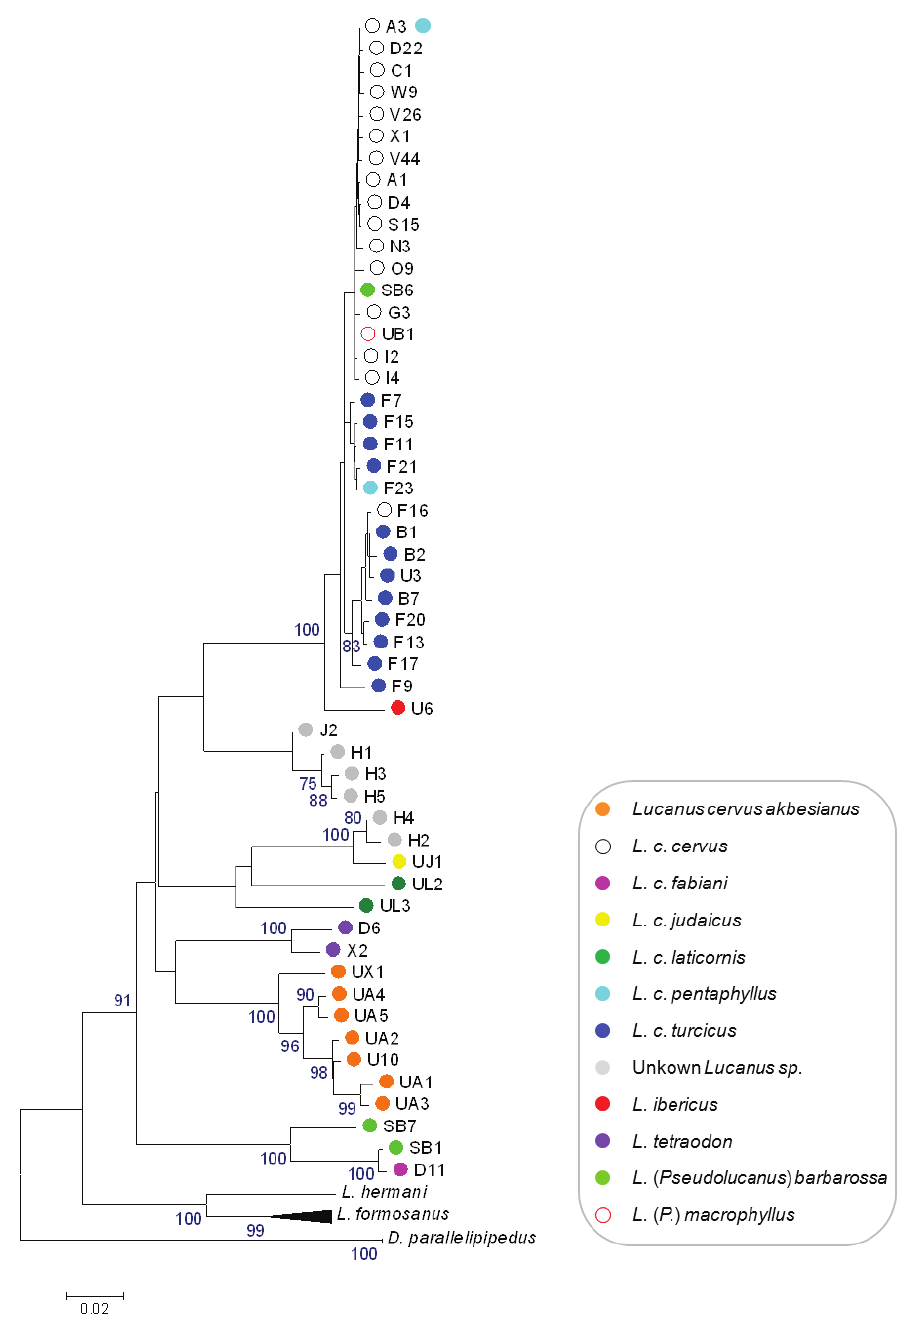
Figure 1. Bootstrap consensus NJ tree inferred from 10,000 replicates, with a cut off value of 70%, based on K2P-distances between 60 haplotypes of the 3’ end of the COI